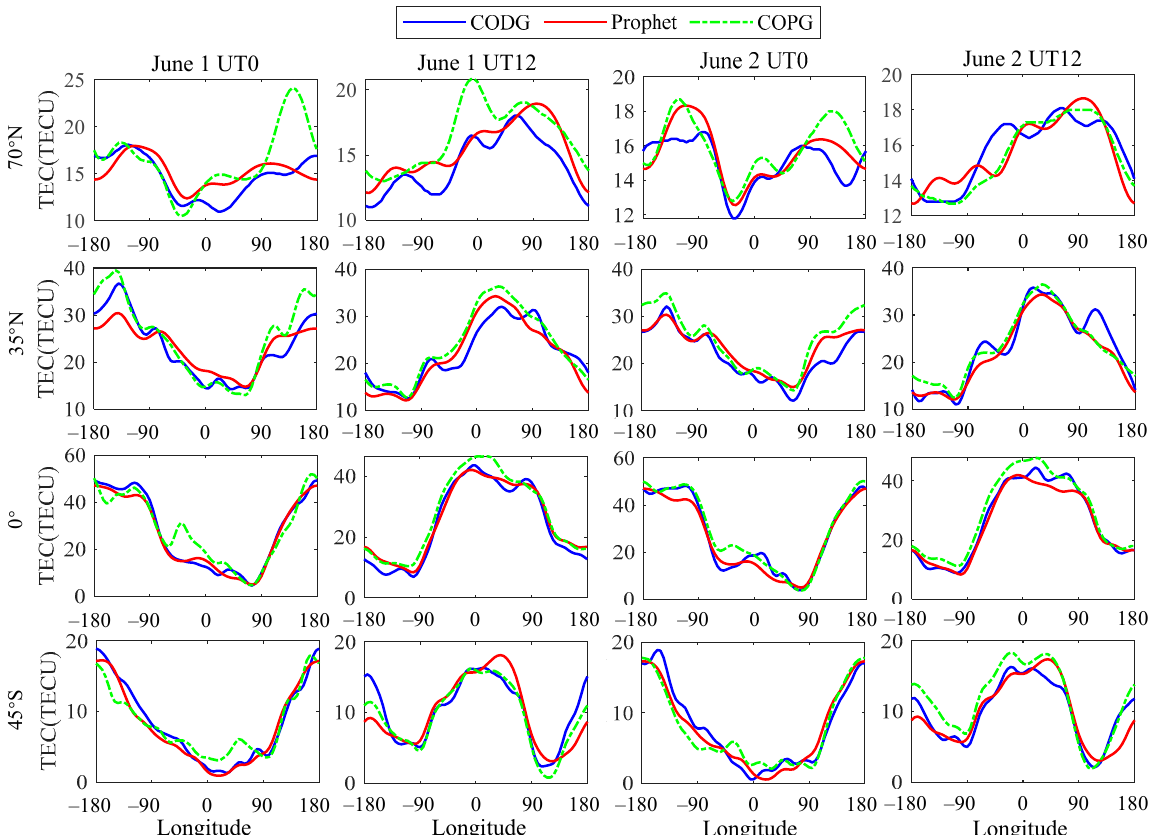
Figure 11. CODG, Prophet forecasted, and COPG values as functions of latitude under high solar activity. The blue solid lines represent the CODG values, the red solid lines represent the Prophet forecasted values, and the green dashed lines represent the COPG values.